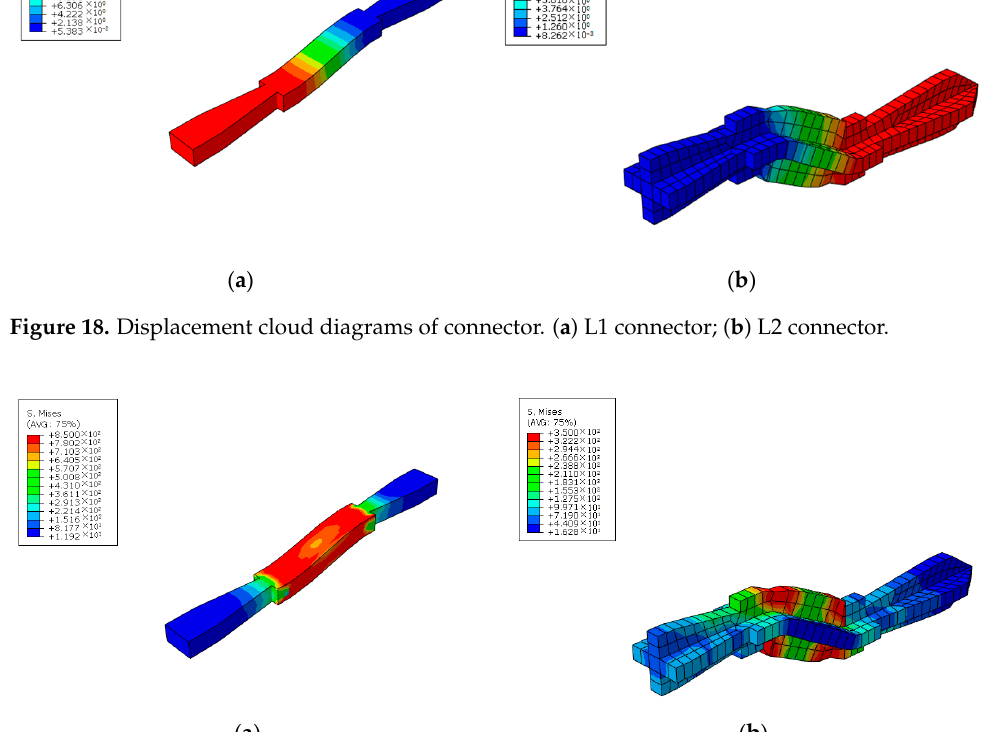
show a nonlinear growth. Finally, after Q1 reaches 93.972 kN and Q2 reaches 85.625 kN, the image gradually flattens, and the connector is